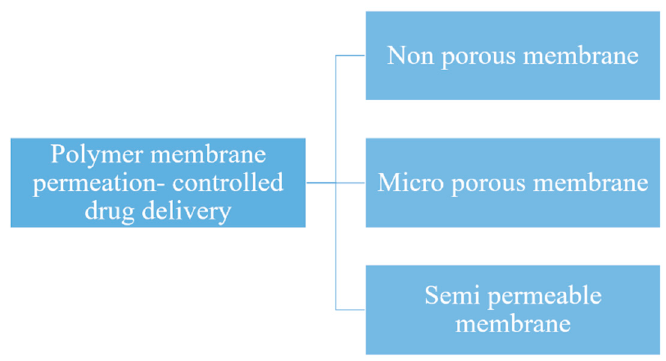
Figure 12. Classification of polymeric membranes for drug delivery.